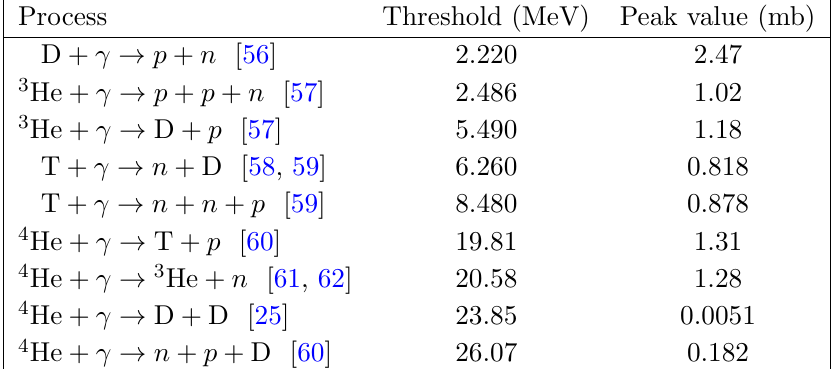
Table 1 . Processes included in our calculation of photodissociation e(cid:11)ects from electromagnetic injections, as well as their threshold energies and peak cross